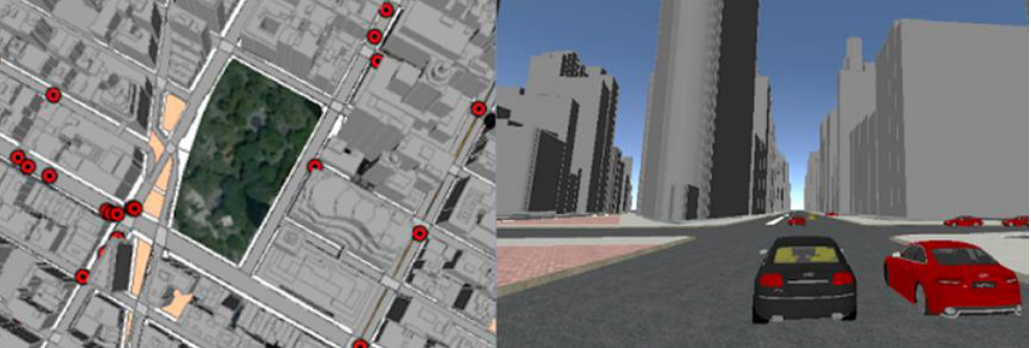
Figure 16. Traffic simulation visualization [22]. Figure 16. Tra ffi c simulation visualization